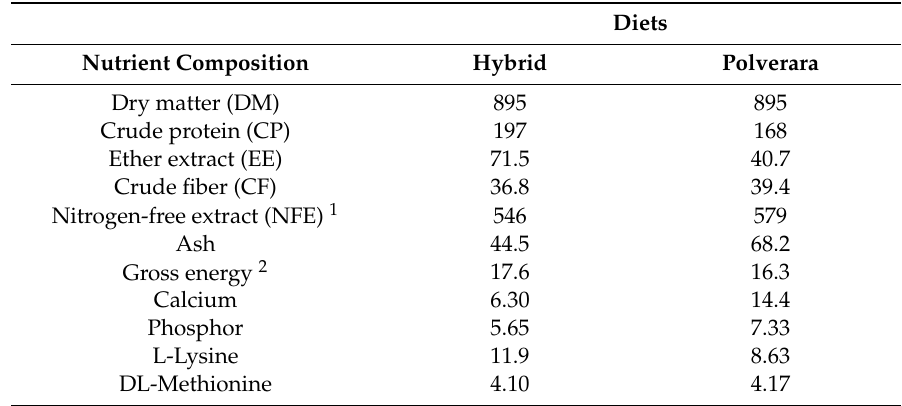
Table 1. Nutrient composition (g / kg as fed) and energy content (MJ / kg as fed) of finisher diets fed to Hybrid and Polverara